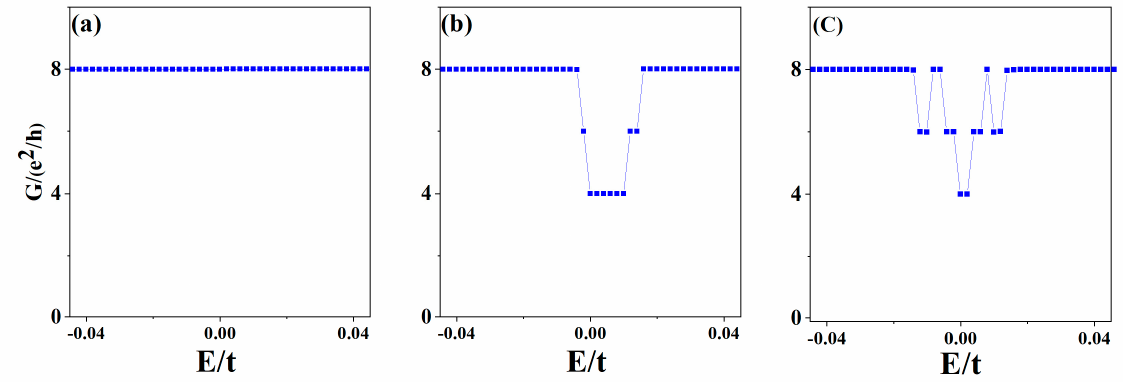
Figure 3. ( a – c ) The two ‐ terminal conductance G as a function of Fermi energy E of Figure